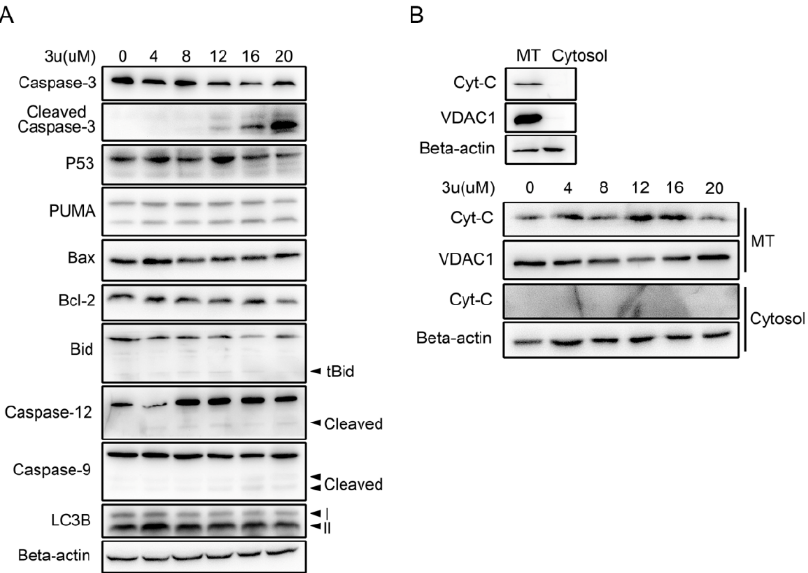
Figure 3. 3u induced apoptosis at high concentrations of 3u depending on whether caspase-3 was caused by the ER-stress or mitochondrial pathways. After exposure to various concentrations of